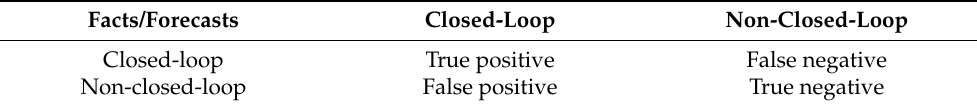
Table 2. Classification of the closed-loop test results.